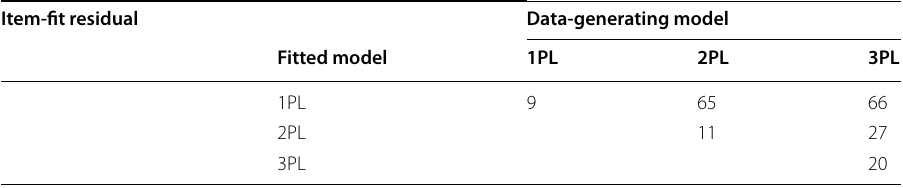
Table 3 Type I error (diagonals) and Power (off-diagonals) of item-fit residuals for differ- ent model combinations for LTT math age